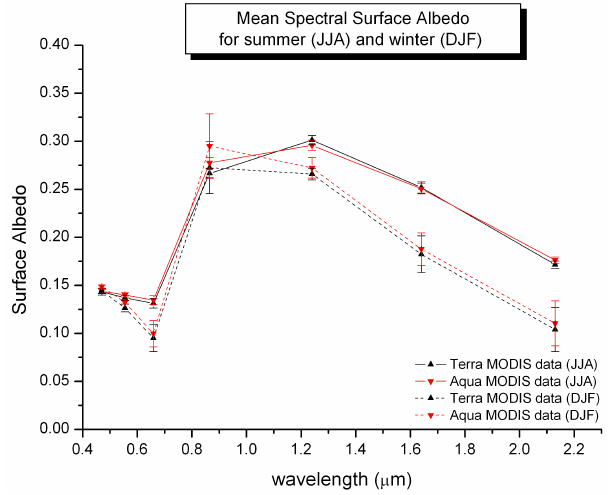
Fig. 2. Mean land-surface albedo at 7 wavelengths, derived from Terra and Aqua MODIS instruments, for the summer (JJA) and win- ter (DJF) months of the 9-year period 2000–2008, at the HCMR sta- tion in Crete. Error bars represent the standard deviation for each